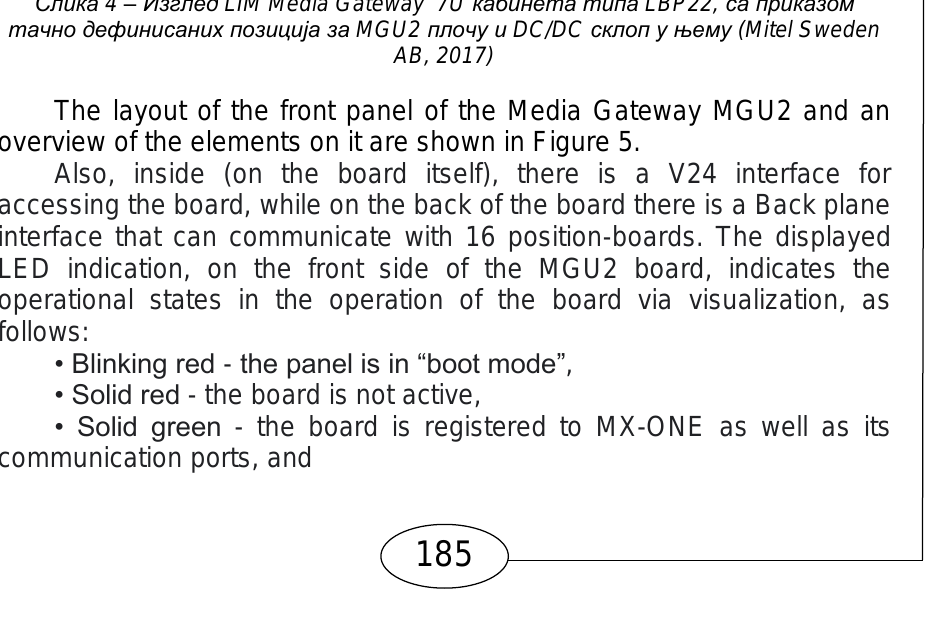
Figure 4 – Appearance of the LIM Media Gateway 7U cabinet type LBP22, with a display of precisely defined positions for the MGU2 board and the DC/DC circuit in it (Mitel Sweden AB,